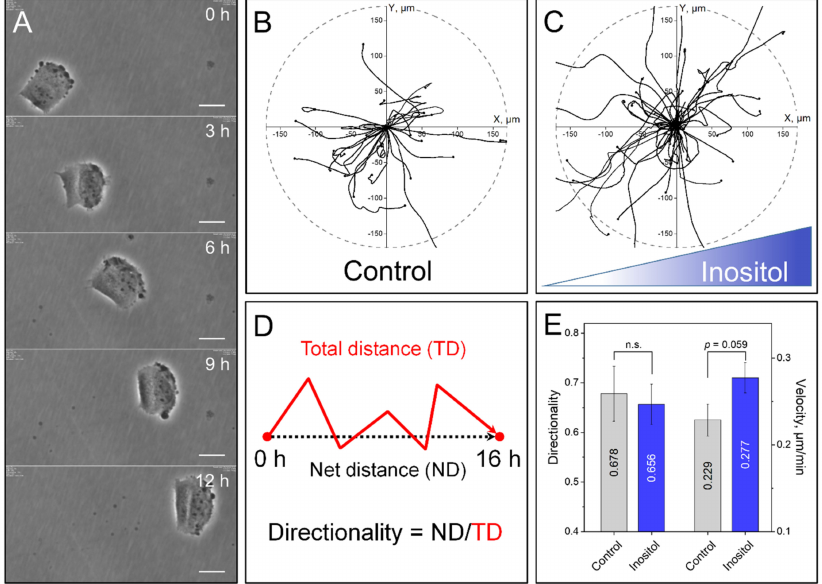
Figure 2. Chemotaxis experiments via µ -slide assays. ( A ) DK-MG cells were automatically tracked by the software TLA, which is able to consistently detect the cells center. Scale bar: 10 µ m. ( B , C ) Plotting of the single tracks in a coordinate system shows directional movement, but without favoring the movement along the gradient, which increased from left to right in the x -axis. N control = 24, N inositol = 42. Endpoints were only partially marked for better visibility of tracks at the center. ( D ) Definition of directionality. ( E ) Cell directionality and total velocity were calculated. Differences in directionality were not significant, while the presence of SOOs slightly increased cell velocity ( ± SD). However, Student’s t -test showed p -values of >0.05, making the differences